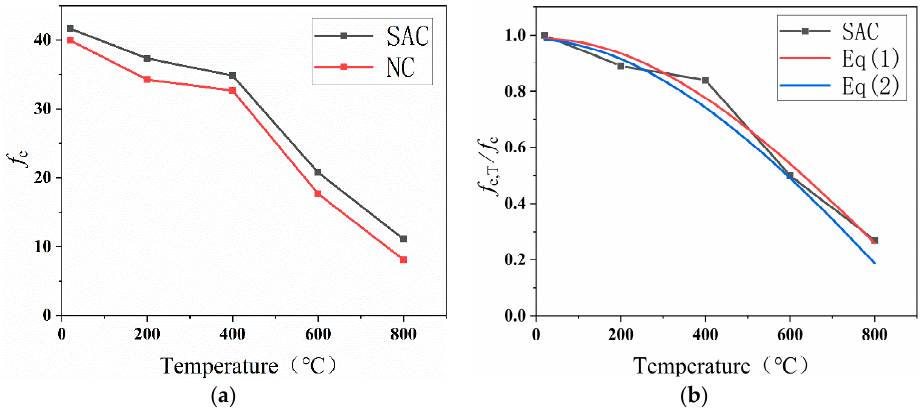
Figure 6. ( a ) Reduction of compressive strength. ( b ) Relative reduction of compressive strength. The splitting tensile strengths of the Scoria aggregate concrete after high temperature Table 3. Splitting tensile strength of specimens after high temperature. and its strength reduction coefficients are shown in Table 3. The splitting tensile strength of the Scoria aggregate concrete specimens decreased with increasing temperature to 84, 73, 37, and 22% of the splitting tensile strength at room temperature. Similarly, Figure 7 shows that the splitting tensile strength reduction coefficient of the Scoria aggregate con- crete was greater than that of normal concrete at all temperatures. Equations (3) and (4) for the residual axial splitting tensile strength of the specimen were similarly obtained by curve fitting.